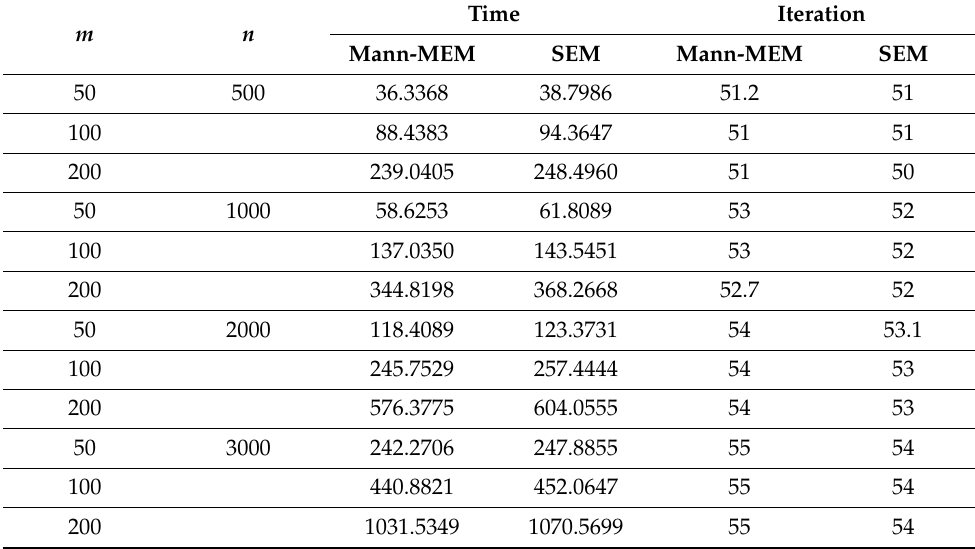
Table 2. Performance of the SEM and Mann-MEM for various dimensions ( n ) and number of constraints ( m